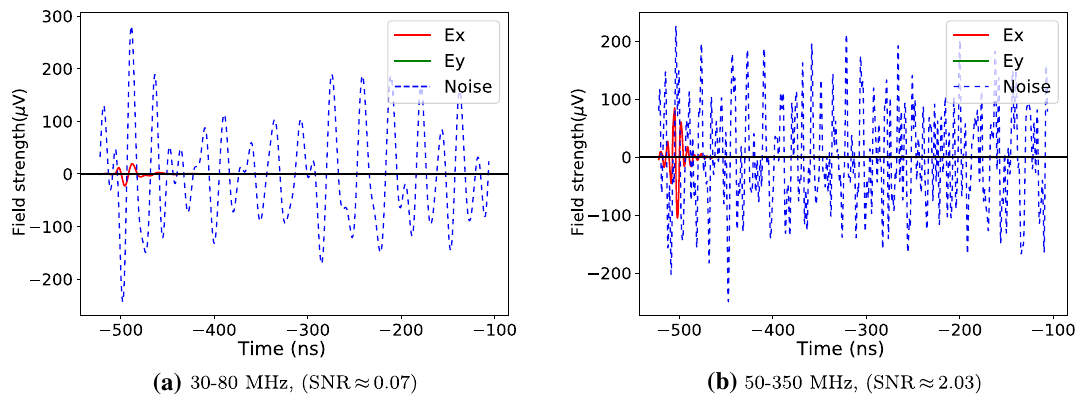
Fig. 1 An updated version of the noise and signal traces shown in Figure 3 of [1]. The simulated signals for an antenna at 107 m from the shower axis receiving signals from a 10 PeV gamma-ray shower are the same as those shown in [1]